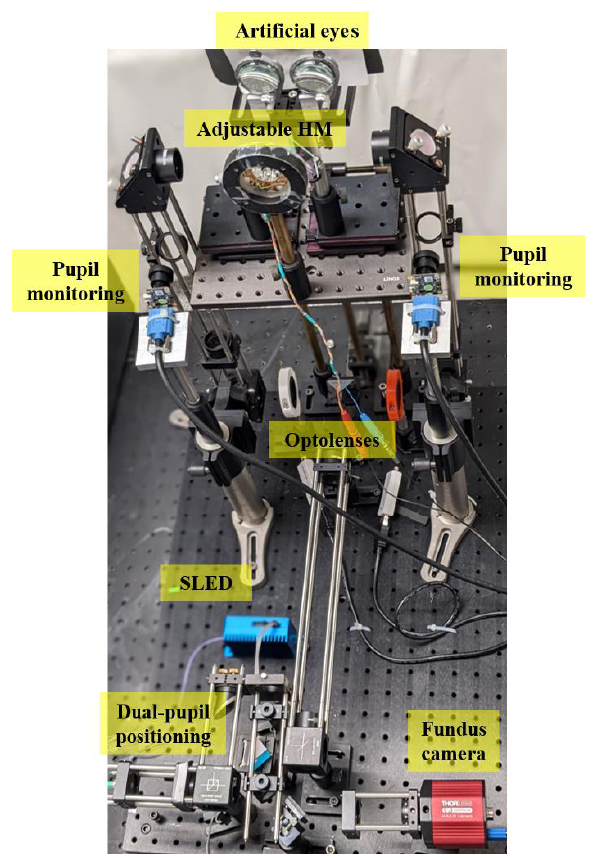
Fig. 1. Top view of the binocular DP system.